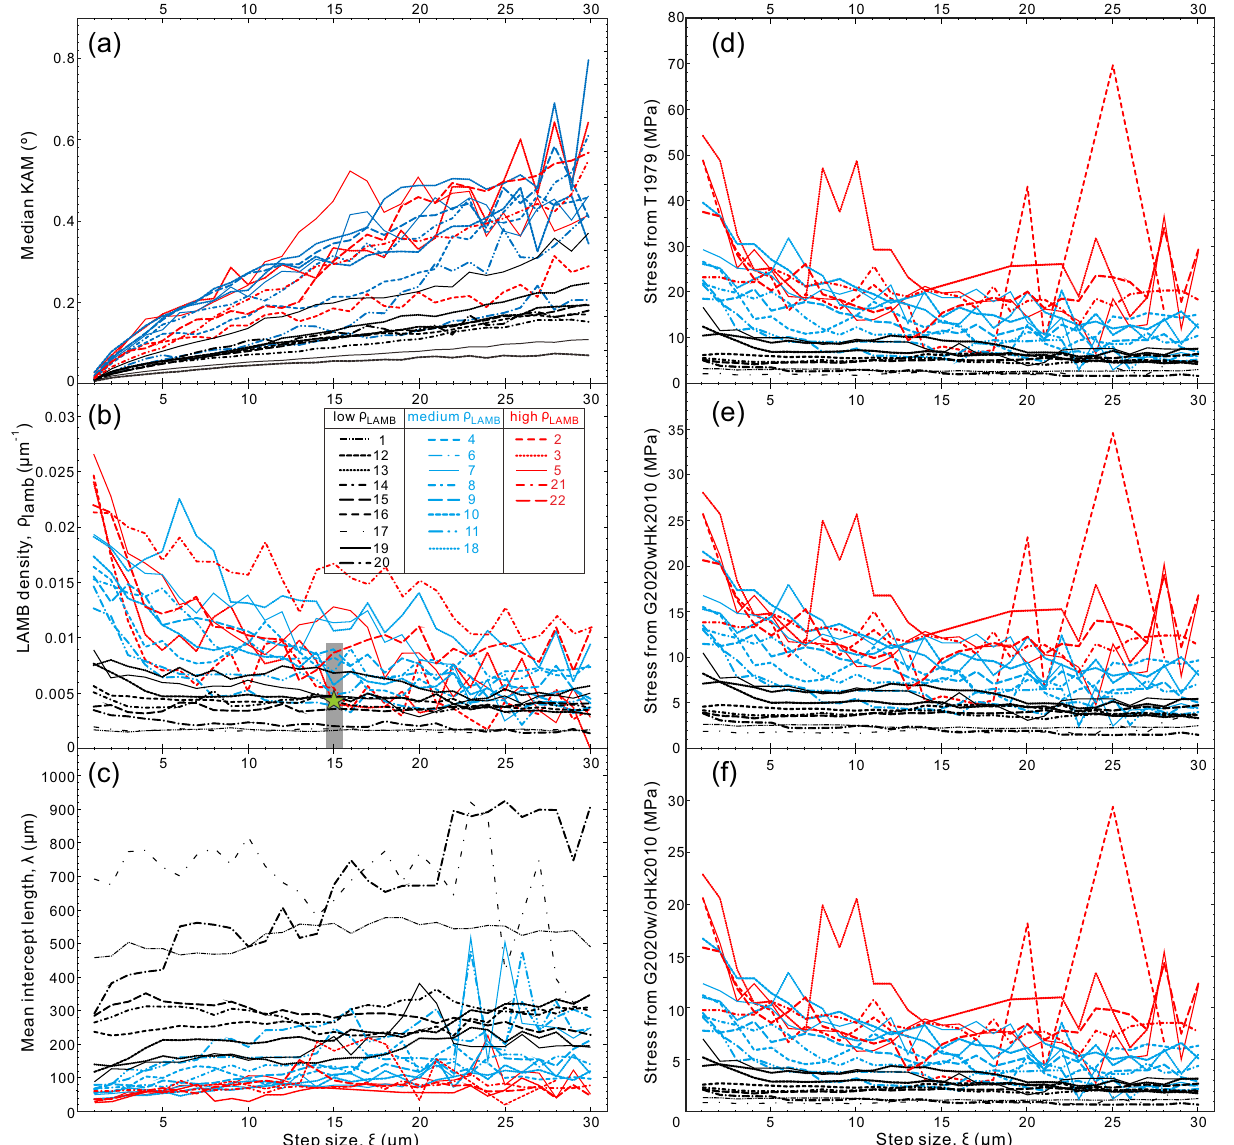
Figure 6. Variations of ( a ) median KAM, ( b ) LAMB density, ( c ) intercept length, and ( d – f ) stress with step sizes from 1 to 30 μm in the 22 analyzed olivine grains, which are classified into low-, medium- and high-ρ LAMB grains. For the large-area EBSD mapping data using the step size of 15 μm, the grey bar is the range of arithmetic mean plus and minus one standard deviation, and the green star is area-weighted average. Some grains (e.g., grain-2 and grain-3) yield null values of mean intercept length for some step sizes, because they show only one (or zero) LAMB and these data are excluded as outliers. Stress is estimated using subgrain-size piezometers provided by ( d ) T1979, ( e ) G2020wHK2010, and ( f )